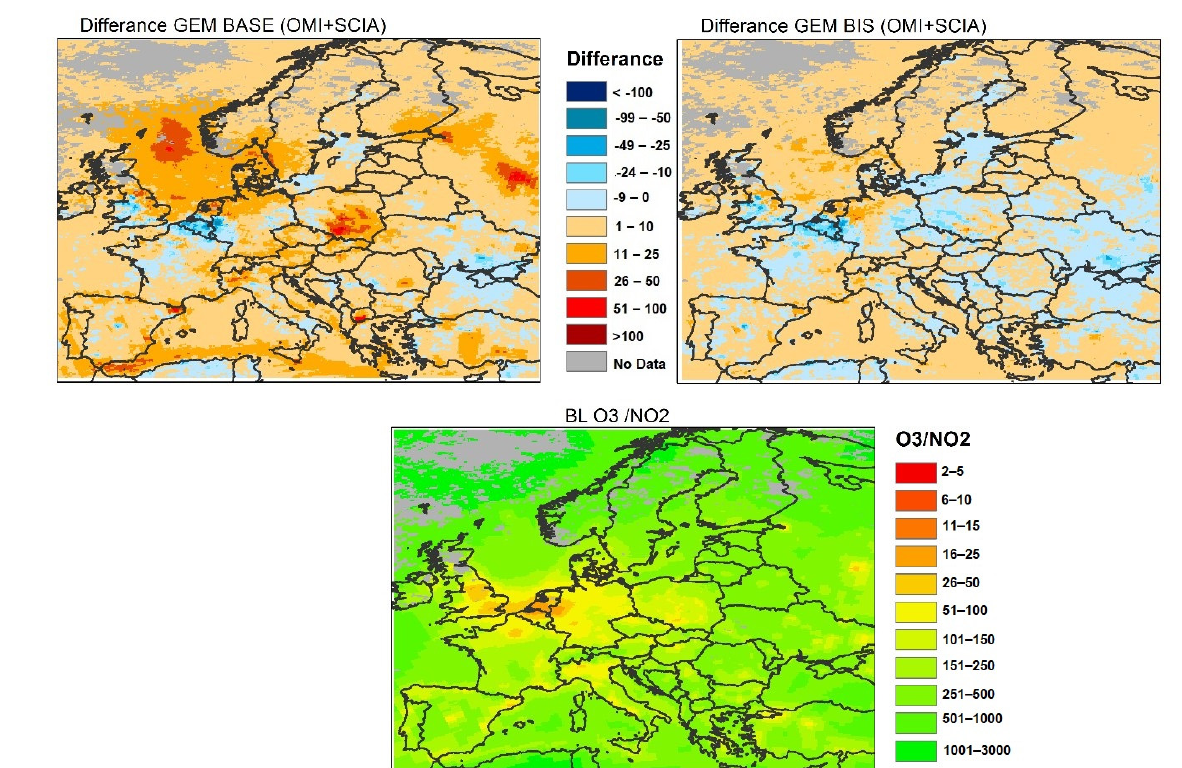
Figure 9. The difference between NO 2 tropospheric columns derived from the model results and observations from satellite (OMI + SCIAMACHY) for the Base and Bis scenarios and ratio O 3 /NO 2 column for June 2011.